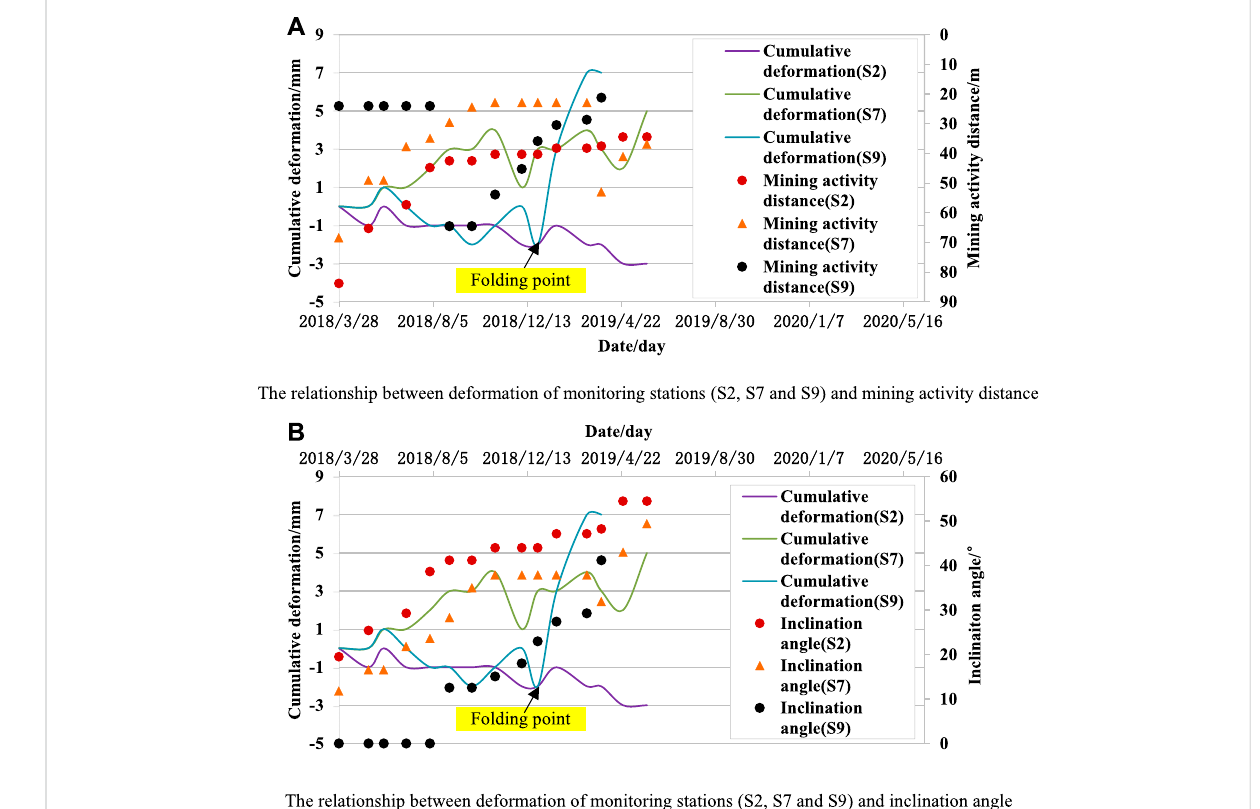
FIGURE 8 Relationship between deformation of monitoring stations (S2, S7, and S9) and mining under polar coordination system. (A) The relationship between deformation of monitoring stations (S2, S7, and S9) and mining activity distance. (B) The relationship between deformation of monitoring stations (S2, S7, and S9) and inclination